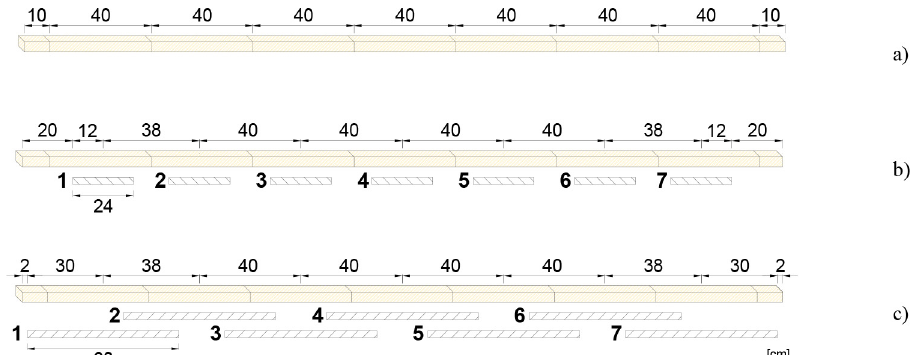
Fig. 2. Location for the sequential bending tests (dimensions in centimeters): a) visual inspection segments; b) gauge length for E m,l (in shade); c) gauge length for E m,g (in